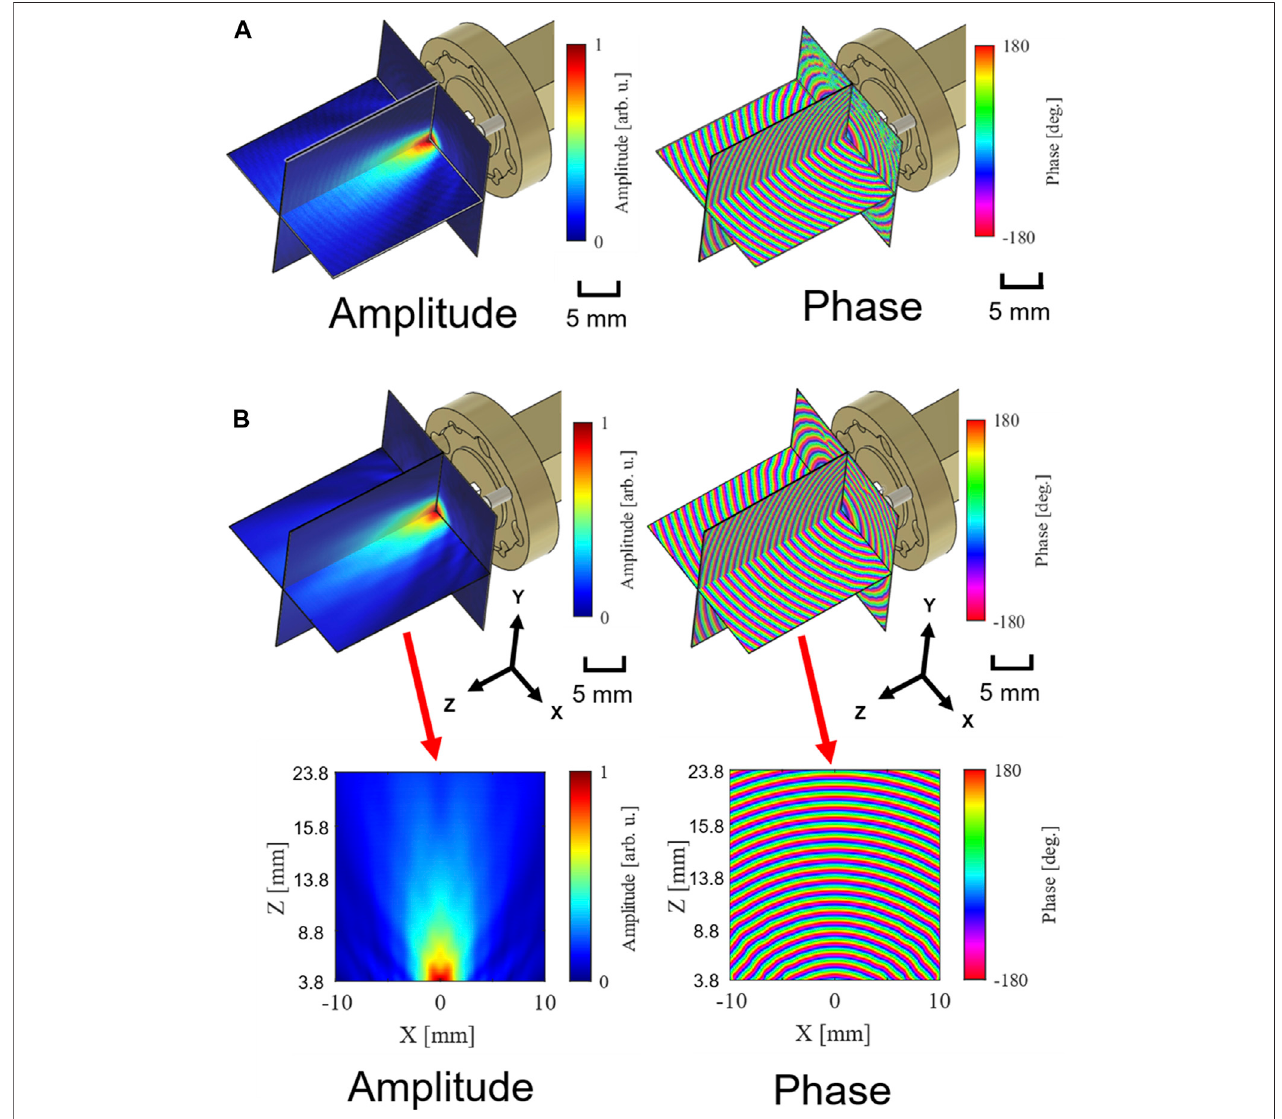
FIGURE 3 | Amplitude and phase distribution of the THz wave radiated from DCA. The waveguide and DCA are depicted by the polygon data (A) Experimental results (B) Simulation results.